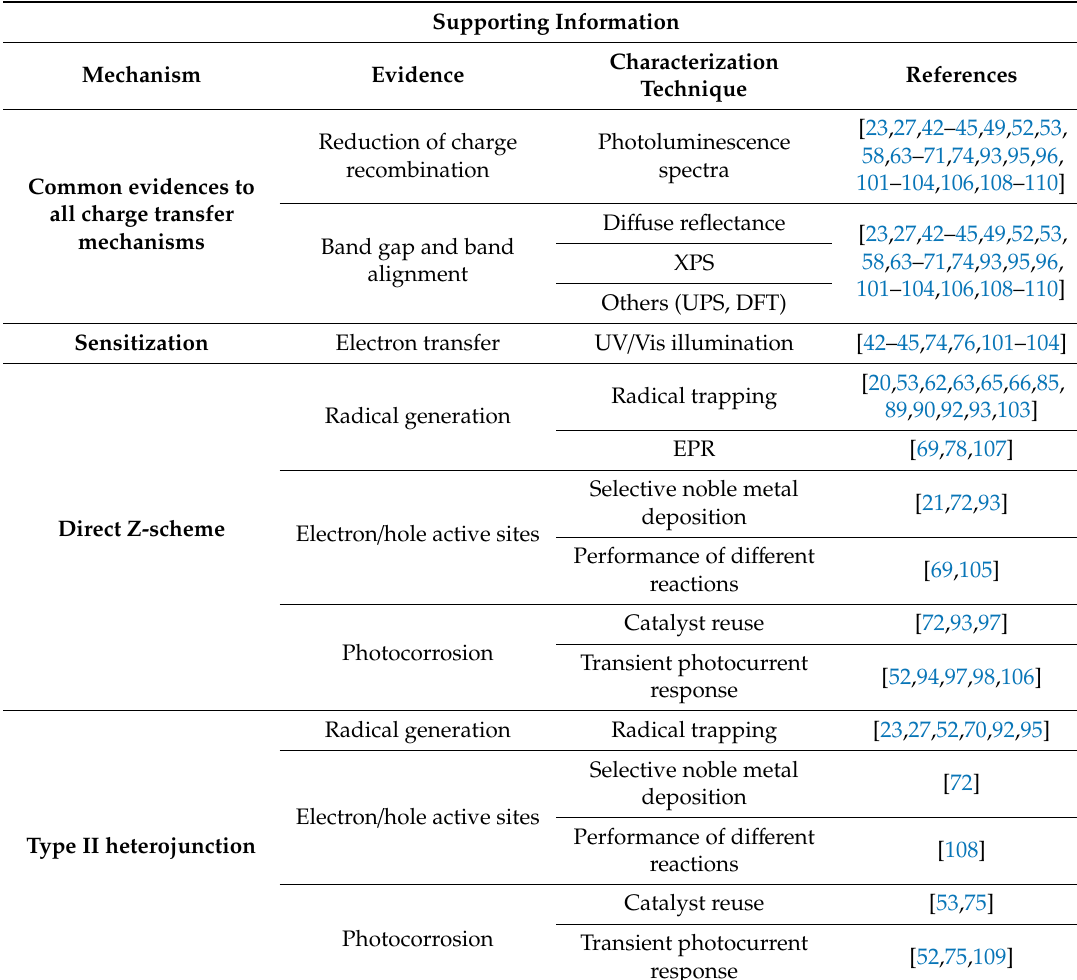
Table 3. Summary of the mechanisms and related characterization